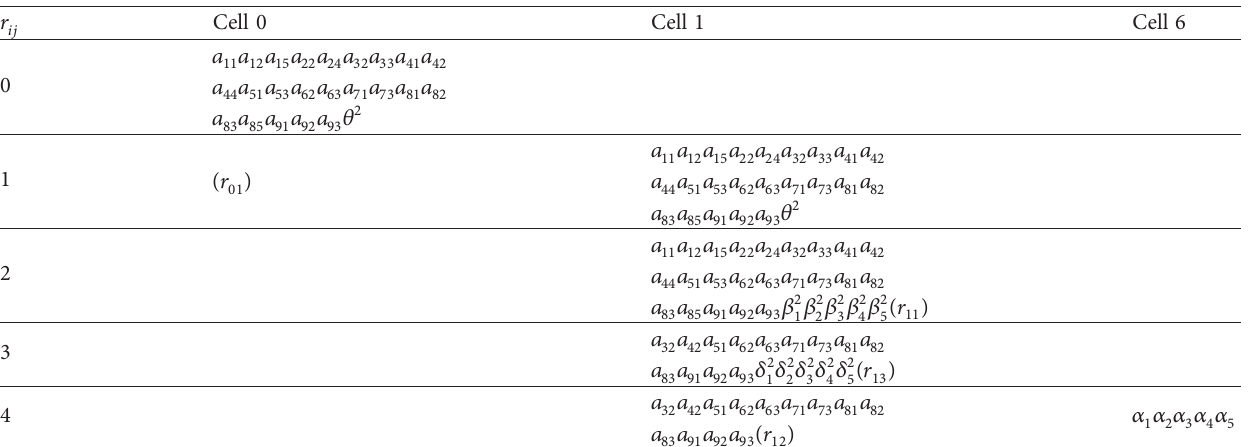
Table 3: Generation of frequent 1-itemsets.